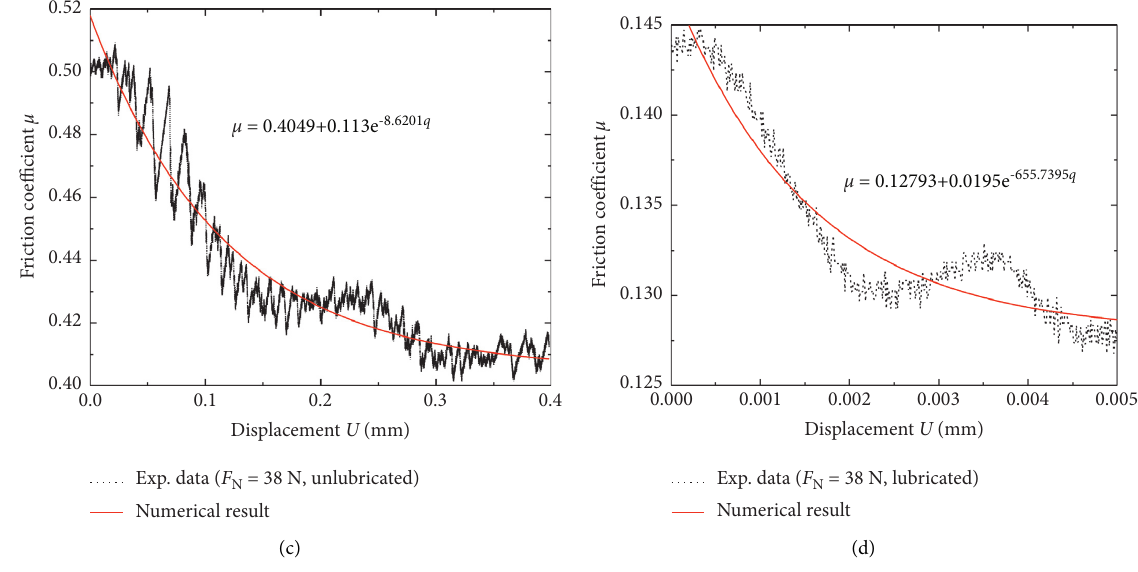
Figure 7: Fitting of the friction coefficient versus displacement ( V � 22 . 78 μ m/ s )